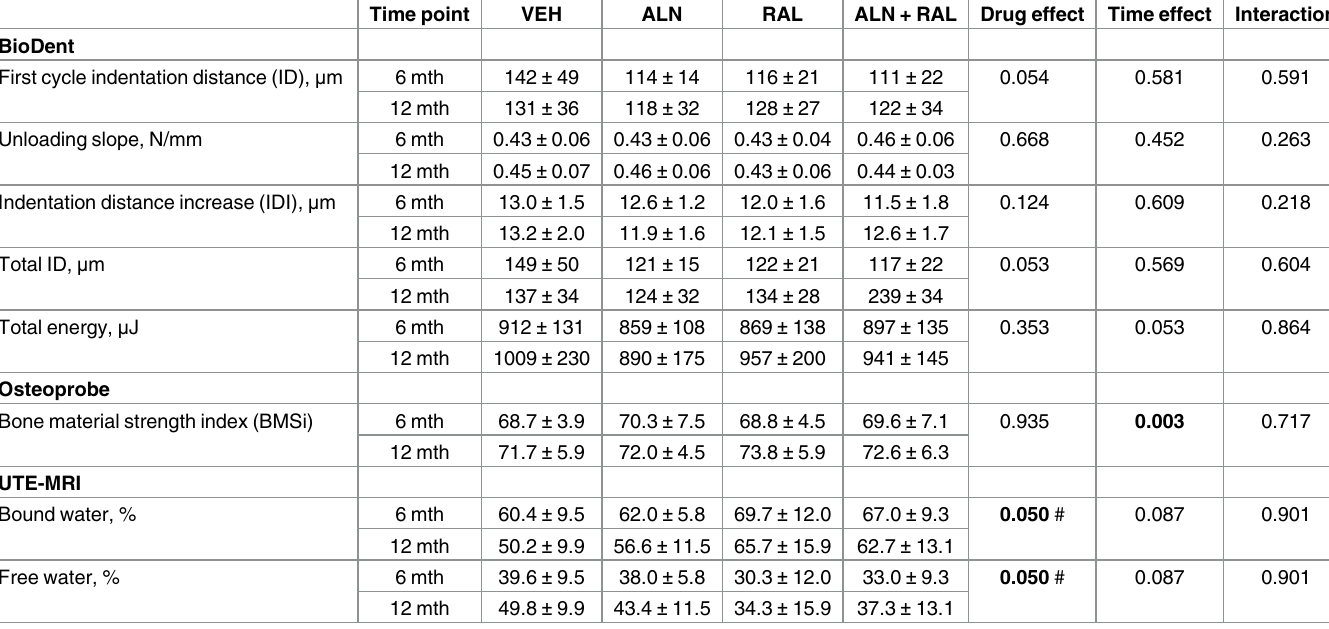
Table 3. In vivo tibia indentation and hydration properties after 6 and 12 months of